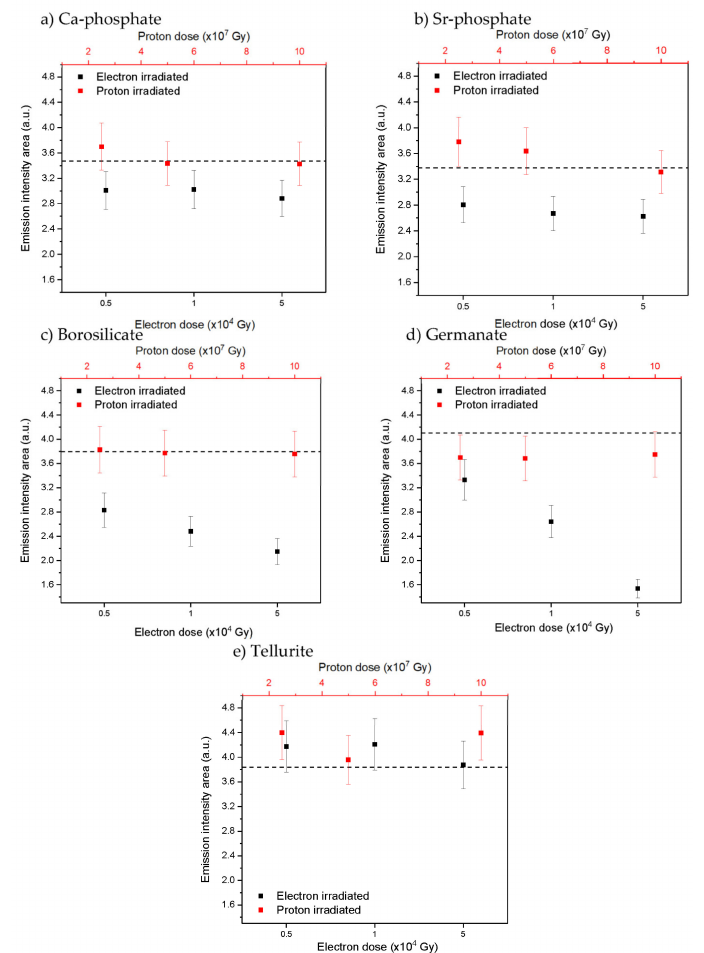
Figure 5. Yb 3+ emission intensity area ( λ exc. = 963 nm) after irradiation with varying doses for Ca- phosphate ( a ), Sr-phosphate ( b ), borosilicate ( c ), germanate ( d ) and tellurite ( e ) glasses, respectively. Dashed line shows emission intensity area for as-prepared samples, error bars ±